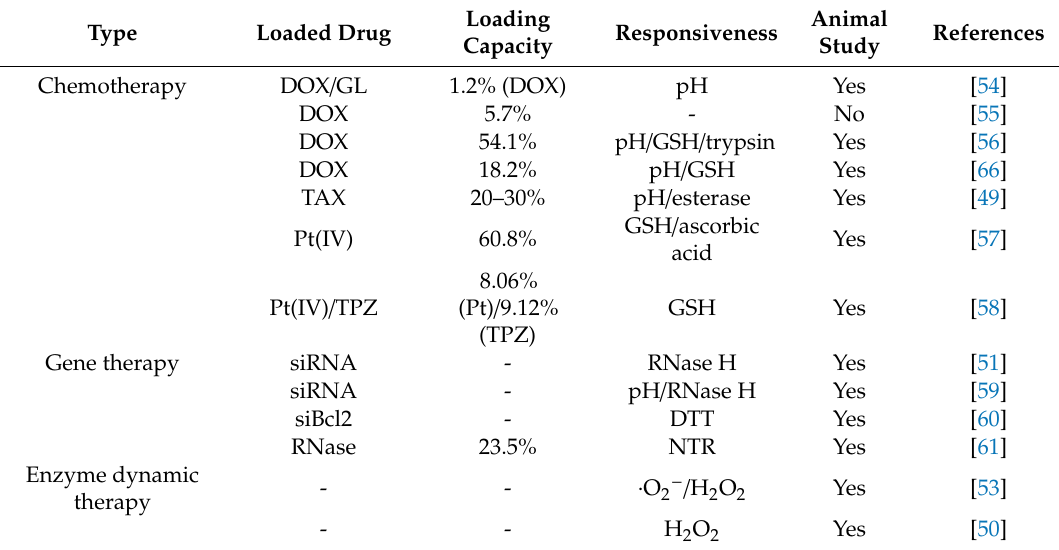
Table 2. Summary of the nanogels for cancer therapy by loaded drug, loading capacity, responsiveness and animal